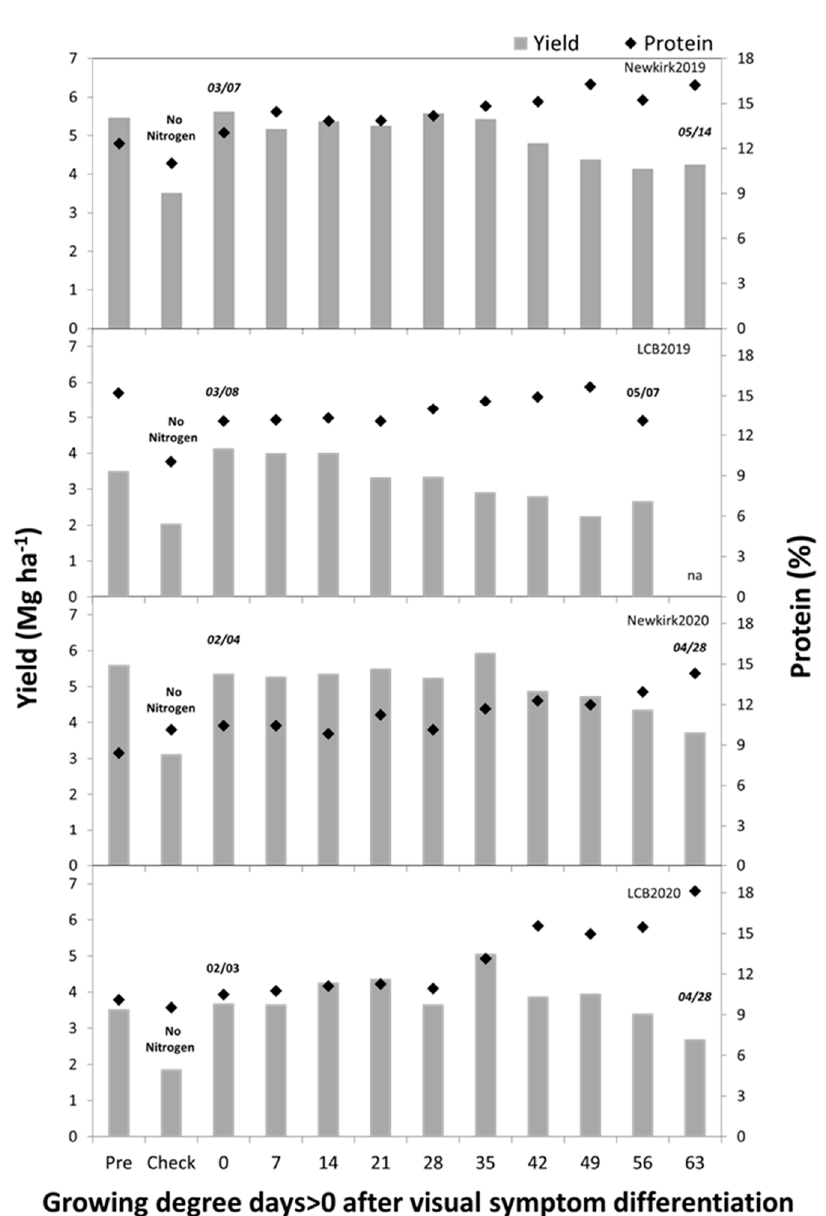
Figure 3. Winter wheat grain yield and protein response to the application of 100 kg N ha − 1